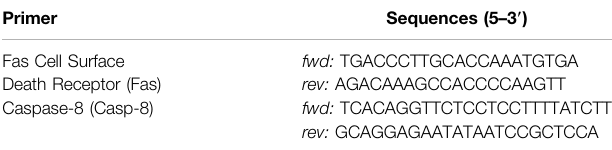
TABLE 1 | Primer sequences for PCR. Primer Sequences (5 – 3 9